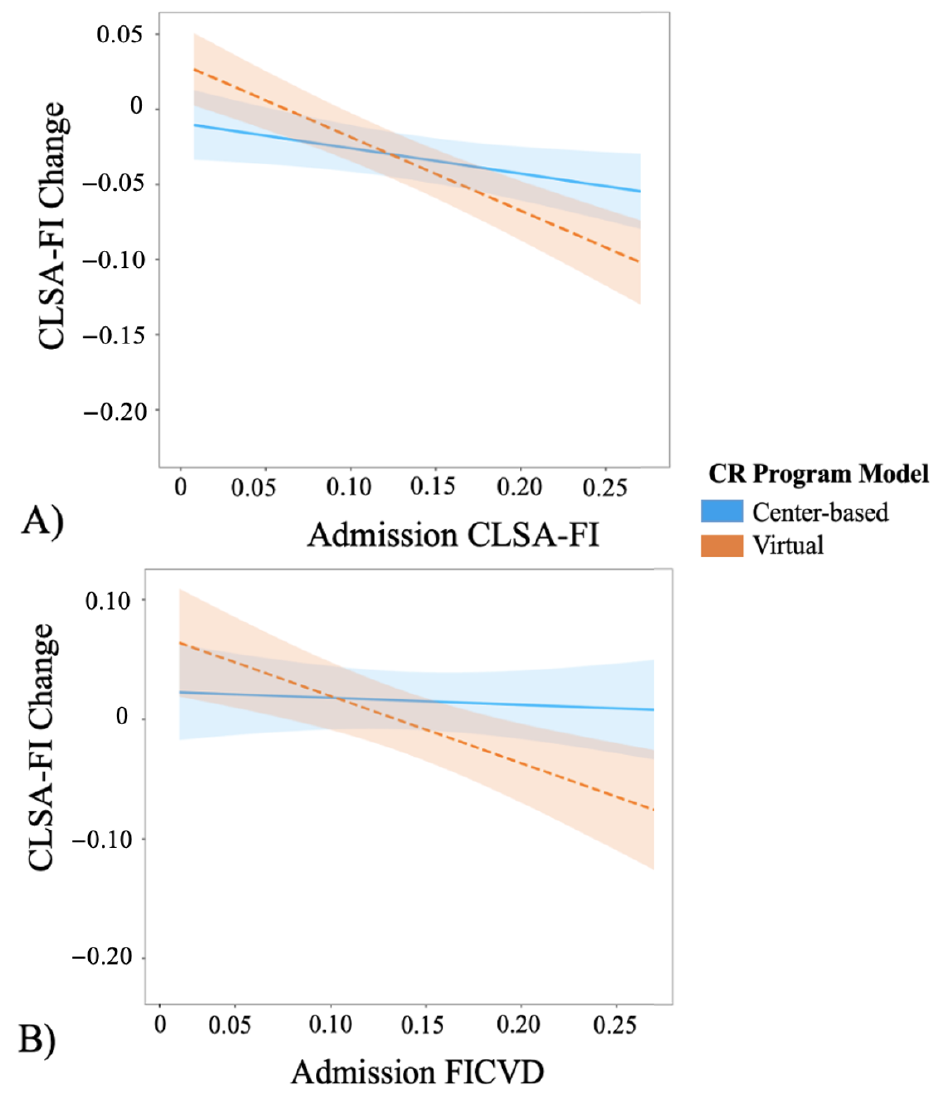
Figure 3. ( A ) Simple slope predicting CLSA-FI change by admission frailty, stratified by CR model; ( B ) Simple slope of FICVD predicting FICVD change by admission frailty, stratified by CR model. Shaded bands surrounding regression line represent beta 95% confidence intervals.